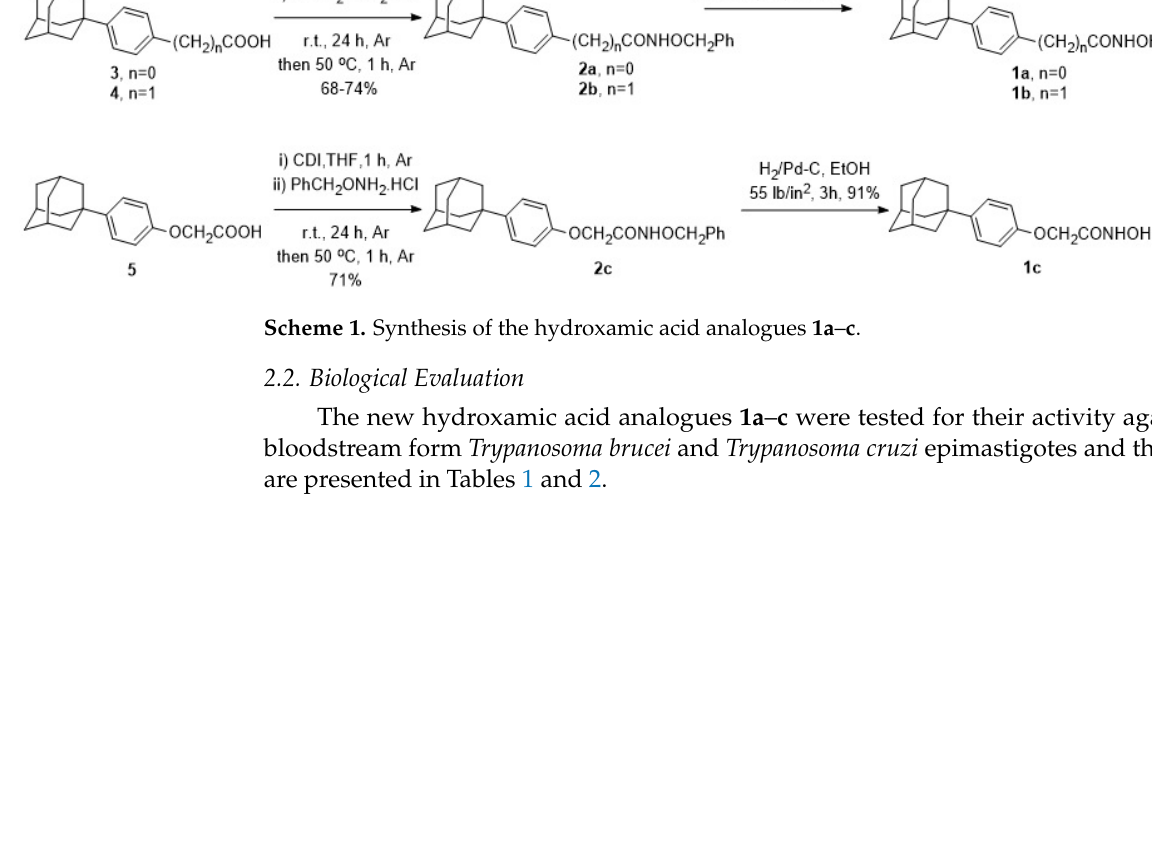
Table 1. Anti- T. brucei screening of derivatives 1a – c .